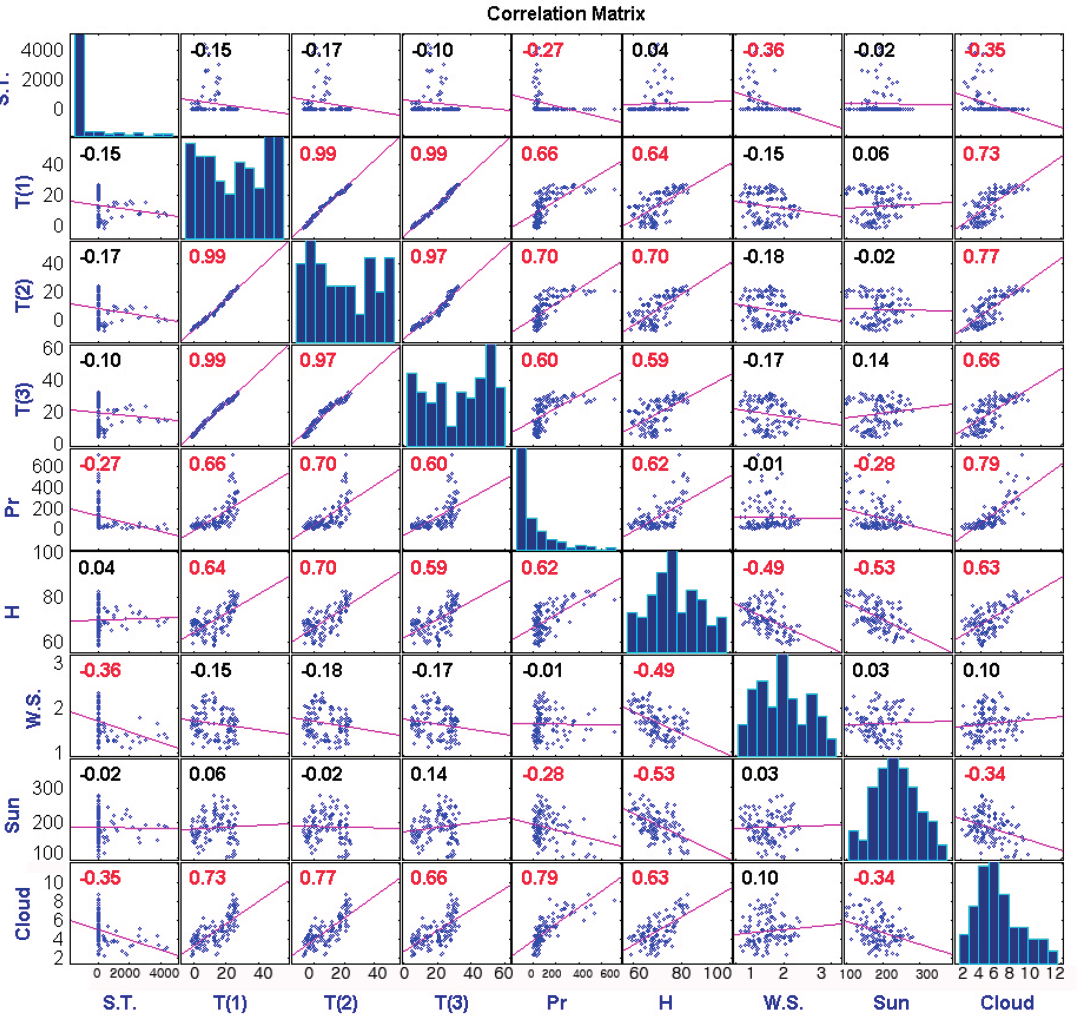
Figure 5. Scatter plot of scrub typhus and each variable, the number indicates Pearson’s correlation coefficient : S.T; Scrub typhus, T(1); mean temperature (°C), T(2); minimum temperature (°C), T(3); maximum temperature (°C), Pr.; precipitation (mm), H; relative humidity (%), W.S.; mean wind speed (m/s), Sun; duration of sunshine (hours), Cloud; cloud amount, and red marks indicate that the correlation coefficient has a statistically significant meaning, and the histogram is a non-dimensional